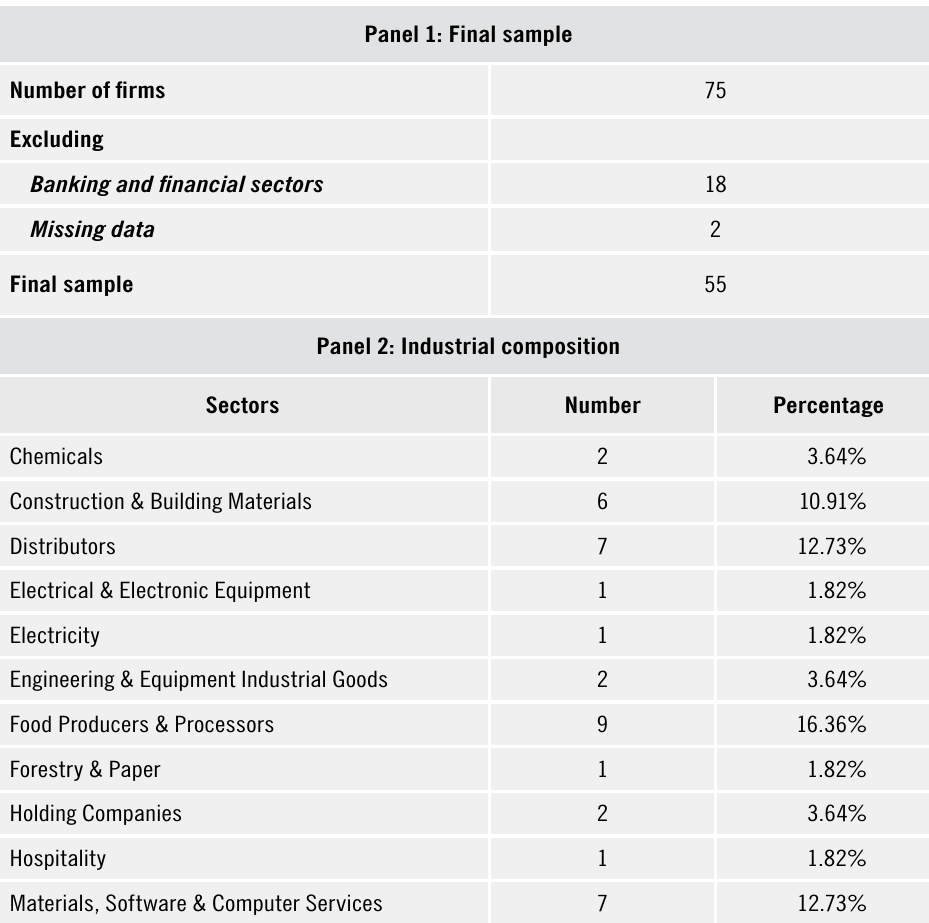
Table 2. Sample selection and